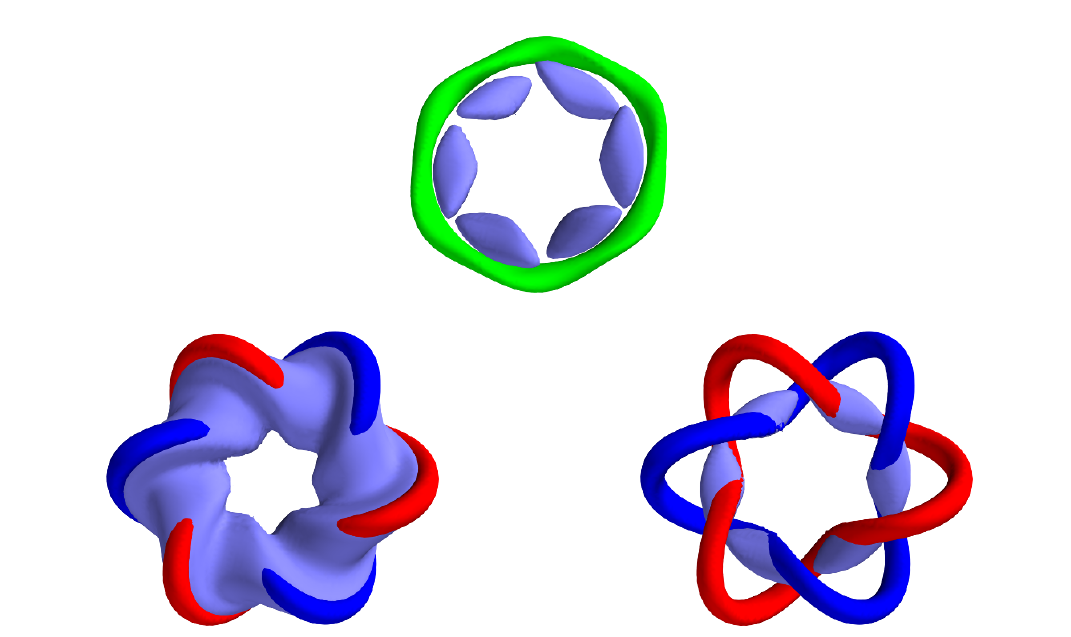
Figure 7 . Isosurface of the energy density of the 3( e A 1 G e A 1 ) A model (2.4) with the potential V = m 2 (cid:30) 12 at c 2 = 0 : 5 ; c 4 = 1 ; m = 4 and E = 80 together with the location curve of the preimage of the (cid:30) 3 = (cid:0) 0 : 9 (upper plot). Bottom row displays these isosutfaces together with the isosurfaces of (cid:30) 1 = (cid:6) 0 : 9 for E = 50 (left) and E = 80